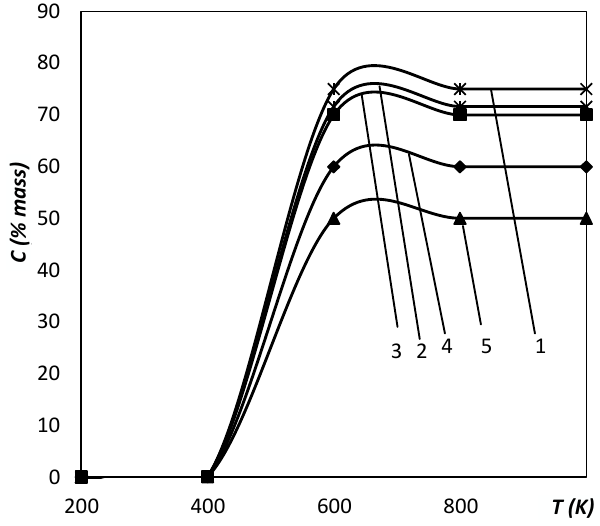
Figure 3. Effect of reaction temperature on concentration of TiF 4 in the product mixture